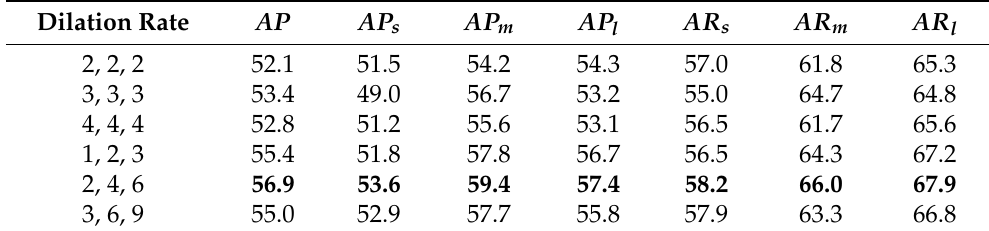
Table 6. Ablation study results for different dilation rates on KITTI. We set two different dilation rate patterns: in one, the dilation size in each branch is identical and expands equally among the branches; in the other, a different dilation size is set for each branch, which then expands independently. According to the results, the dilation rate was set to 2, 4, and 6.